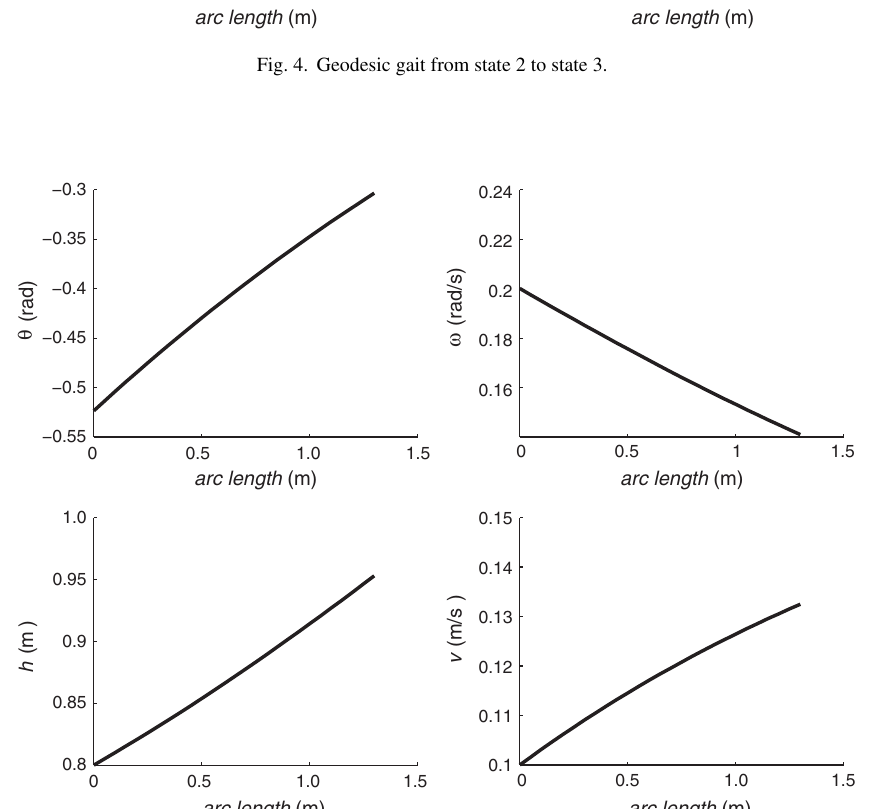
Fig. 5. Geodesic gait from state 4 to state